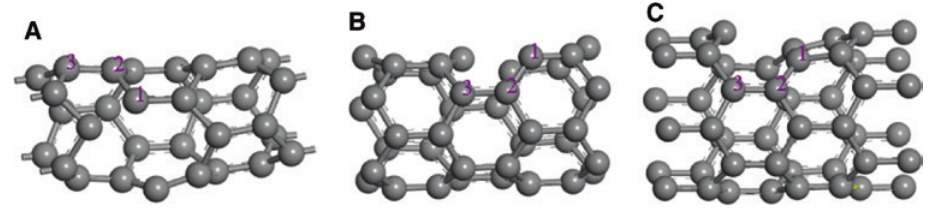
Figure 1: The optimized structure of SV-(n, 0) CNTs (n = 4, 5, 6).